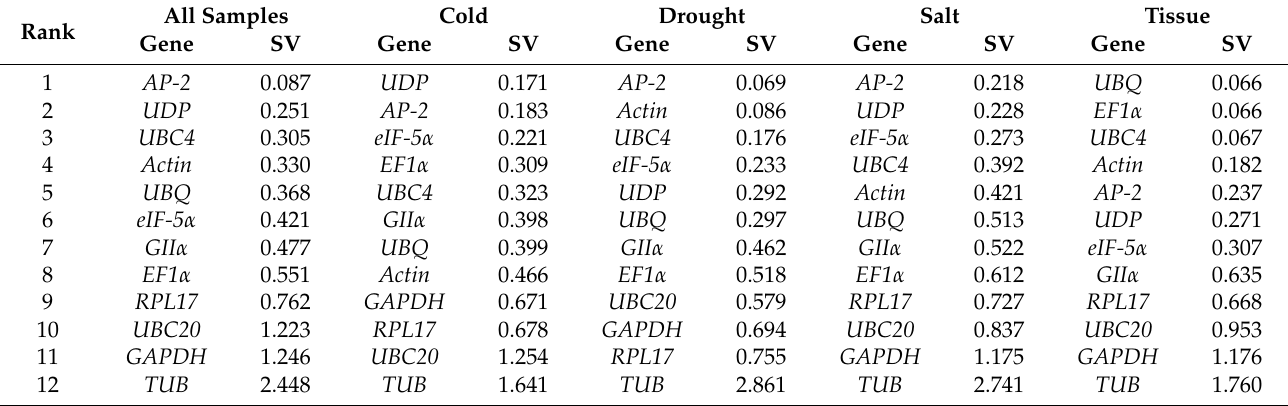
Table 2. Stability analysis of candidate reference genes based on NormFinder algorithm.